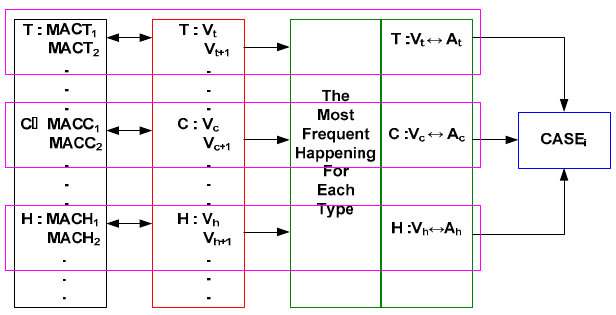
Figure 8. Case generation concepts (T: Temperature, C: CO 2 , and H: Humidity).